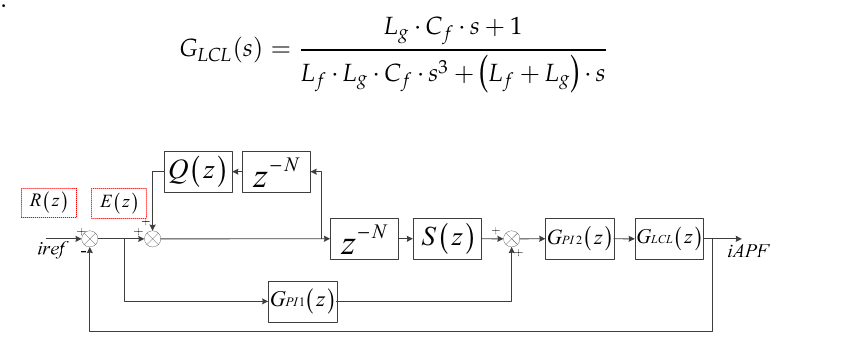
Figure 2. Scheme of hybrid repetitive controller.